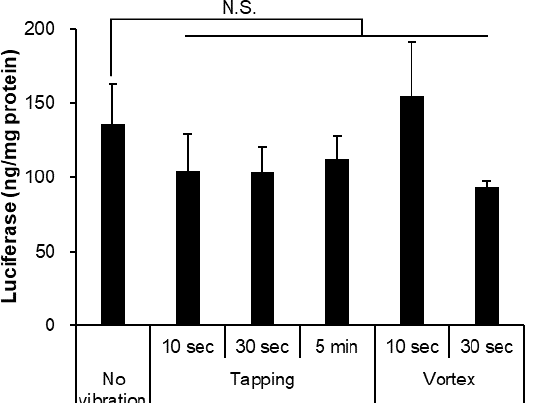
Figure 3. Effects of the vibration for in vitro luciferase assay. The mRNA-LNP treated tapping or vortex with 10 s, 30 s, and 5 min, respectively. Firefly luciferase expression in HepG2 cells was measured at post 24 h adding of each mRNA-LNPs. The LNP-treated vortex for 5 min leaked mRNA substantially and was not able to remain for assay. Data are represented as mean + SD ( n = 3), N.S. indicates not significant versus the non-treatment (Dunnett’s test).